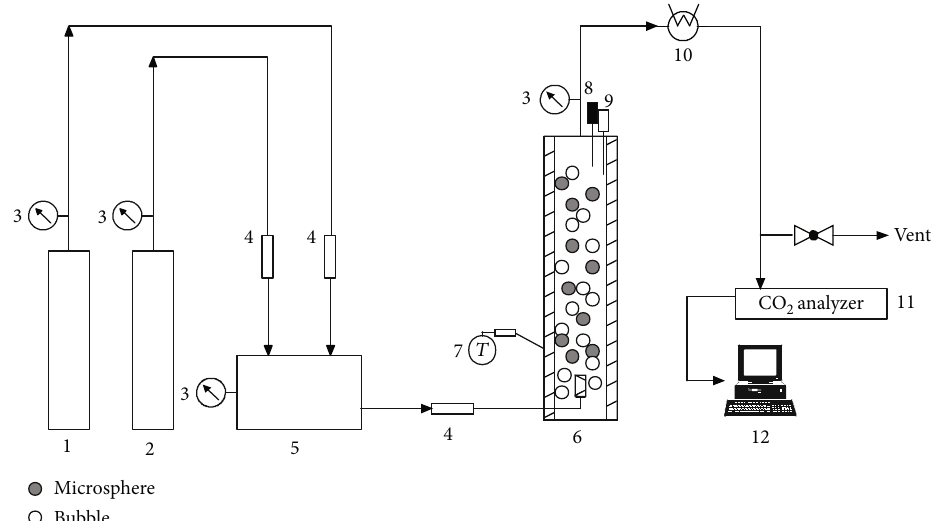
cylinder, (2) CO cylinder, (3) pressure gauge, (4) gas fl ow 2 2